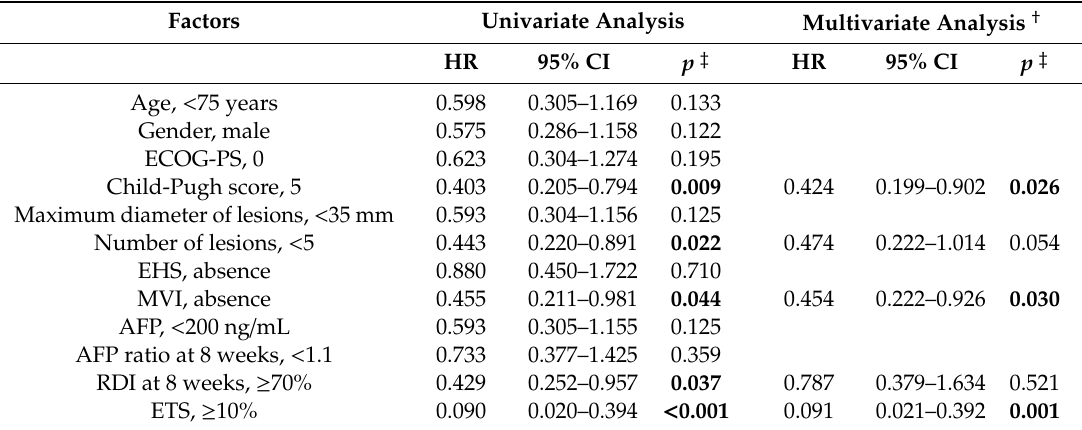
Table 4. Univariate and multivariate analyses for overall survival.